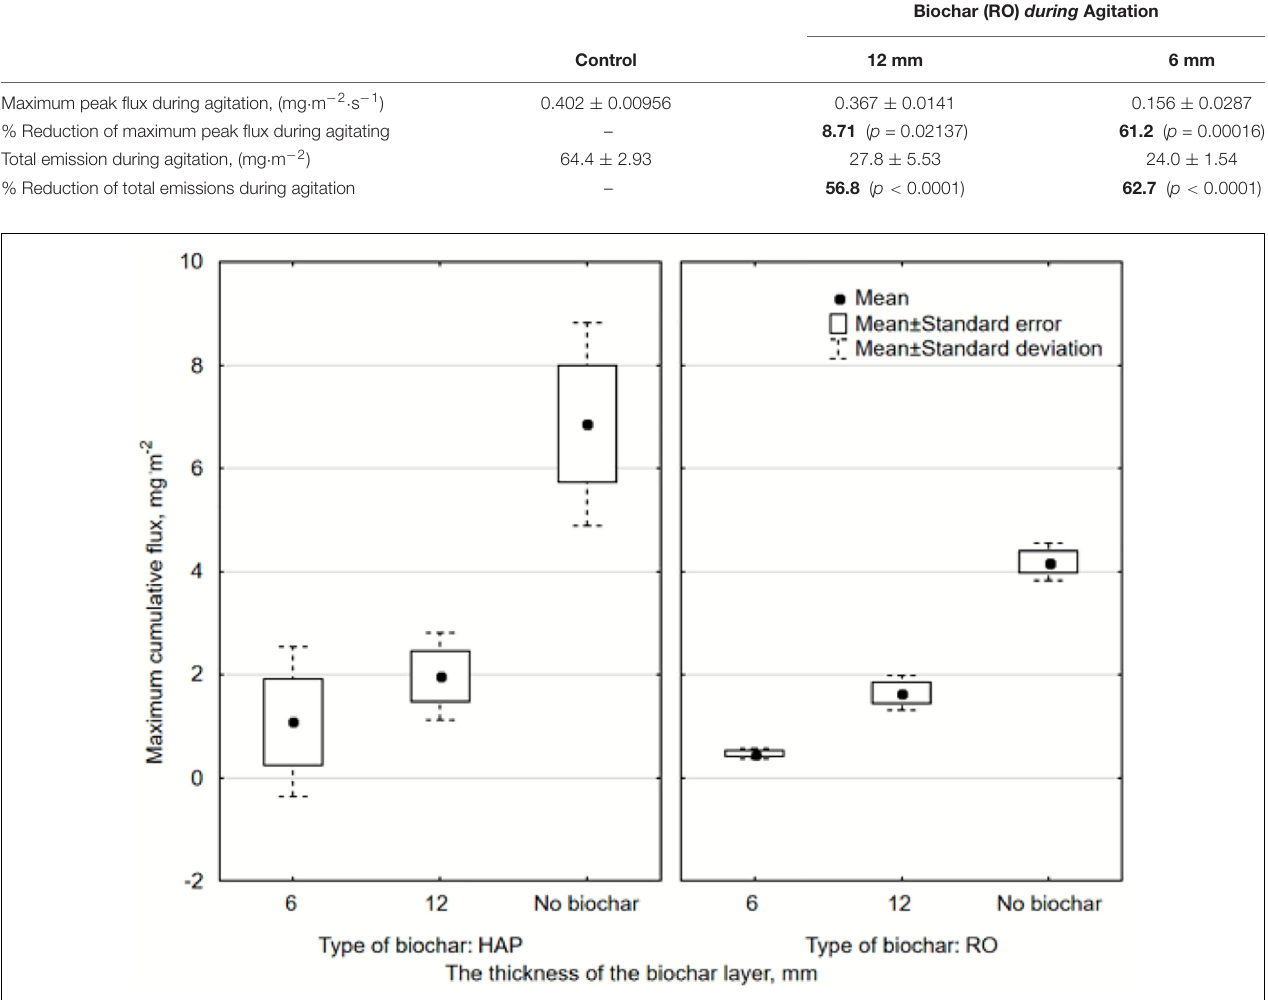
FIGURE 2 | The differences between the maximum cumulative NH 3 flux per biochar type and dose (thickness of the biochar layer). Both HAP treatments and 6 mm RO treatment were significant (p < 0.05), 12 mm treatment was insignificant ( p = 0.107289); No significant difference between the dosages ( Appendix Table 1 ). TABLE 3 | Biochar (RO) treatment: the average flux and cumulative NH 3 emission after agitation (bold font signifies statistical significance). RO Biochar after